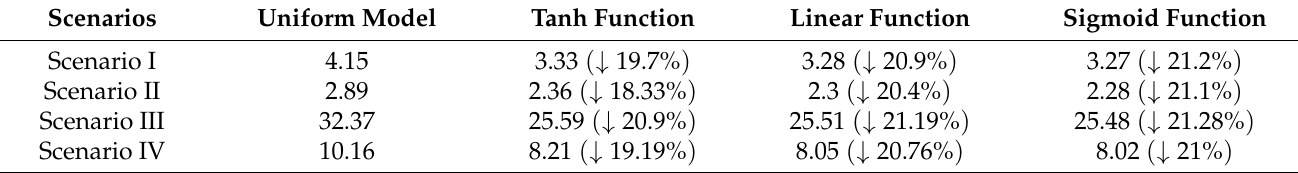
Table 4. Total estimated energy consumption for each scenario under various models (in percentages with total battery capacity of 36 Ah